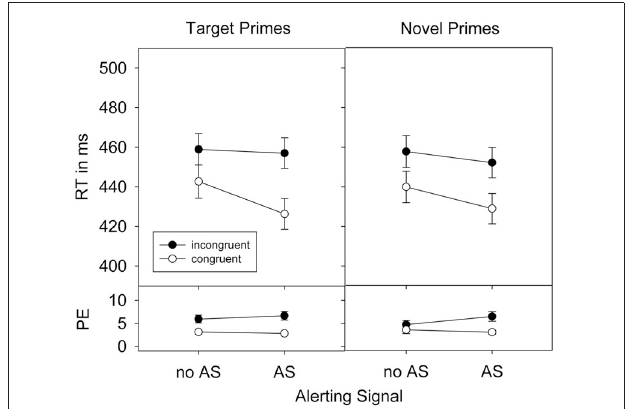
FIGURE 1 | Response times (RTs), standard errors of the means, and percent error (PE) in Experiment 1 as a function of prime-target congruence, prime type, and alerting signal (AS).